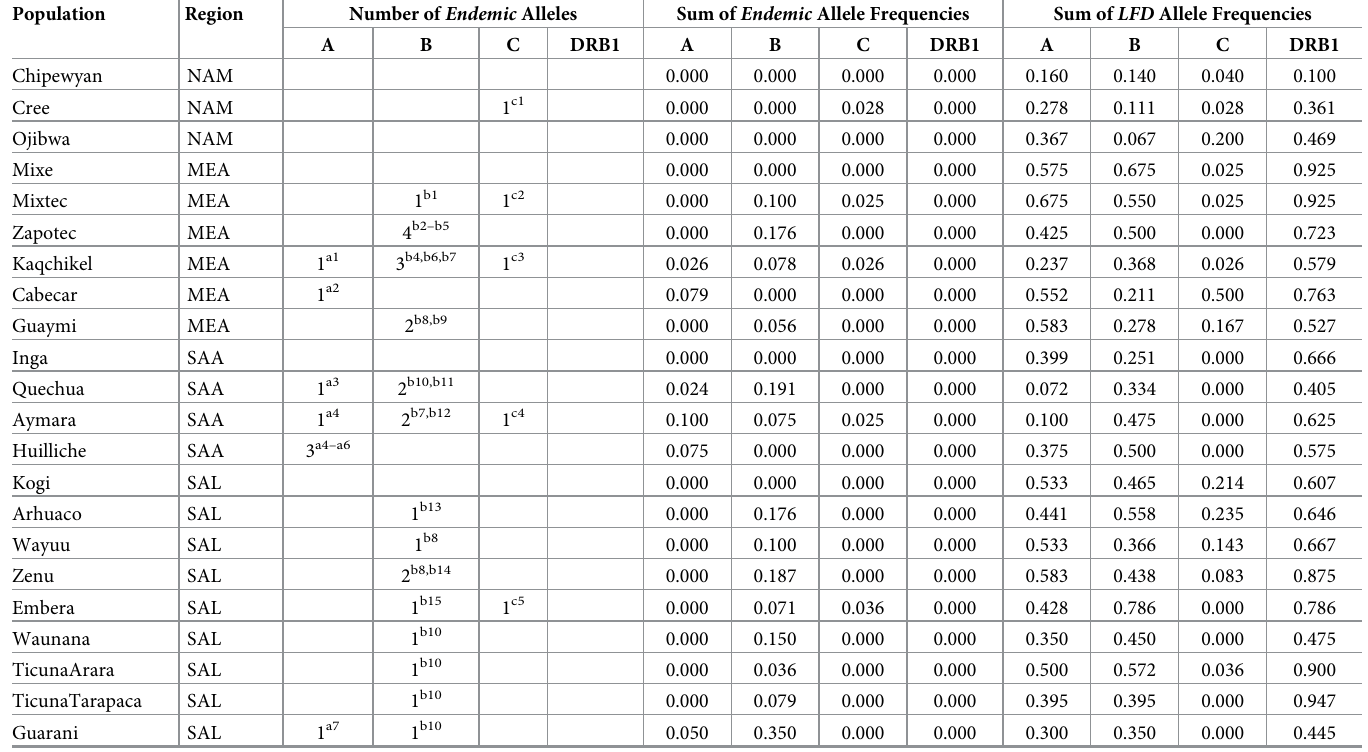
Table 6. Sum of frequencies for alleles in endemic and LFD